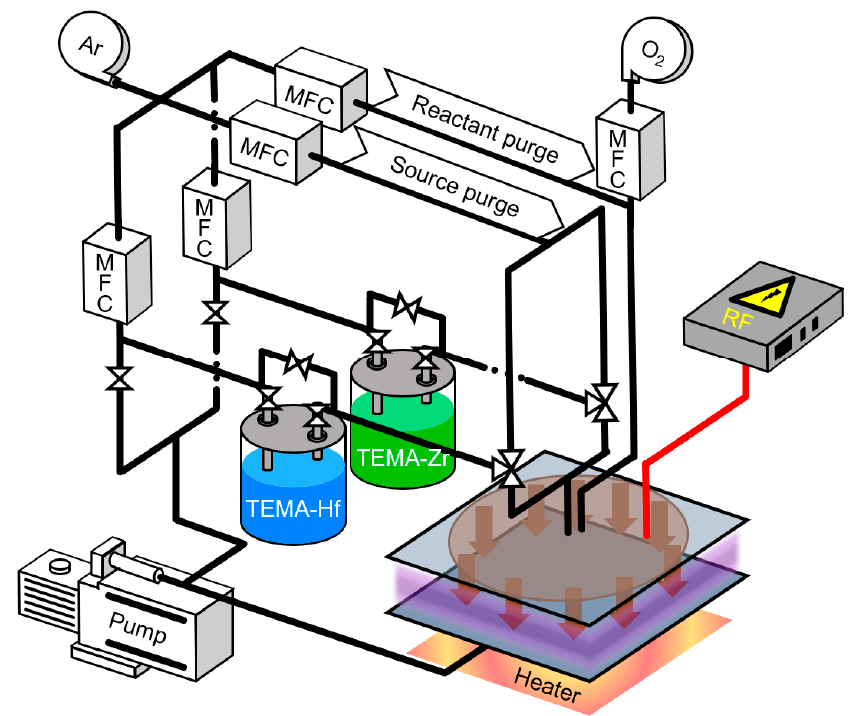
Figure 1. Schematic of PEALD setup used in this study. Table 1. Conditions of HZO thin film deposition by PEALD and processes constituting one cycle.